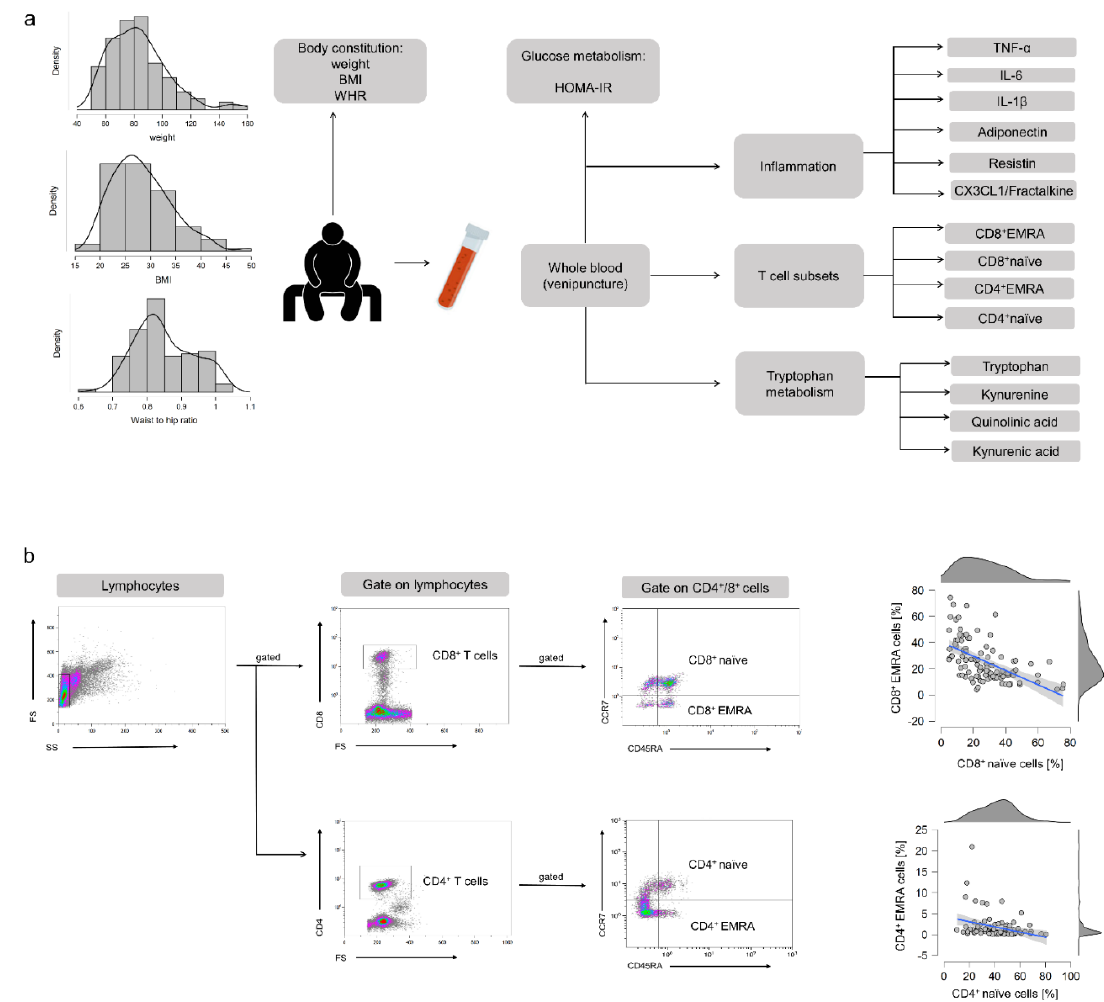
Figure 1. ( a ) Presentation of the study design and the course of analyses. ( b ) Flow cytometric analysis of T cell subpopulations. Lymphocytes were gated using the forward- and sideward scatter. Populations were subdivided into CD4+ T-helper cells and CD8+ cytotoxic T cells. Both cell types were further differentiated into naïve (CD45RA+/CCR7+), central memory (CD45RA − /CCR7+), effector memory (CD45RA − /CCR7 − ), and effector memory re-expressing CD45RA (CD45RA+/CCR7 − ) cells. Associations between naïve and EMRA T cells.